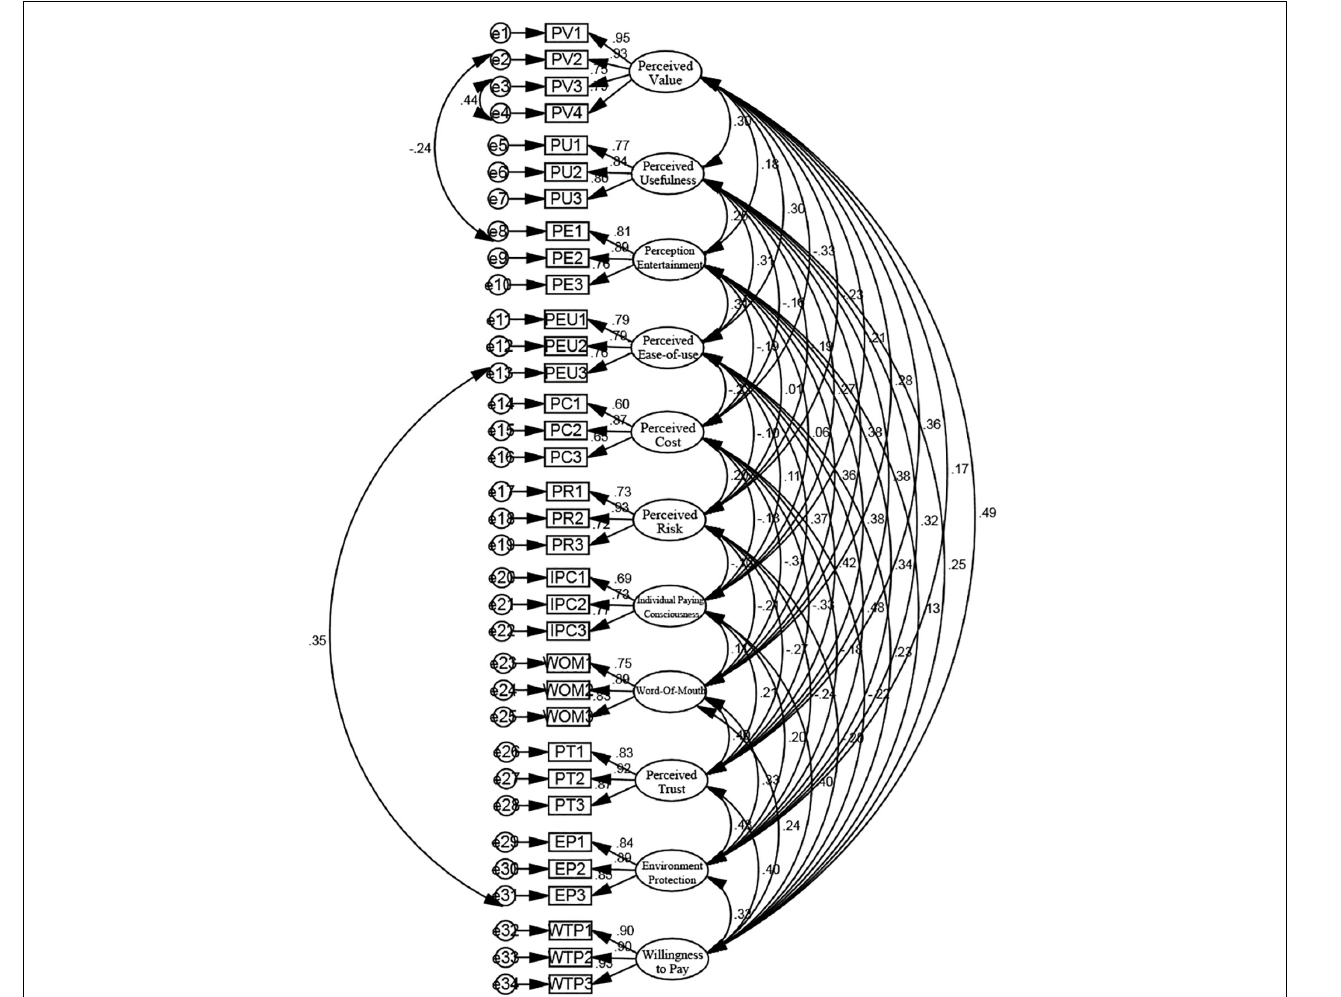
FIGURE 2 | Modified measurement model of influencing factors of users’ willingness to pay in bike